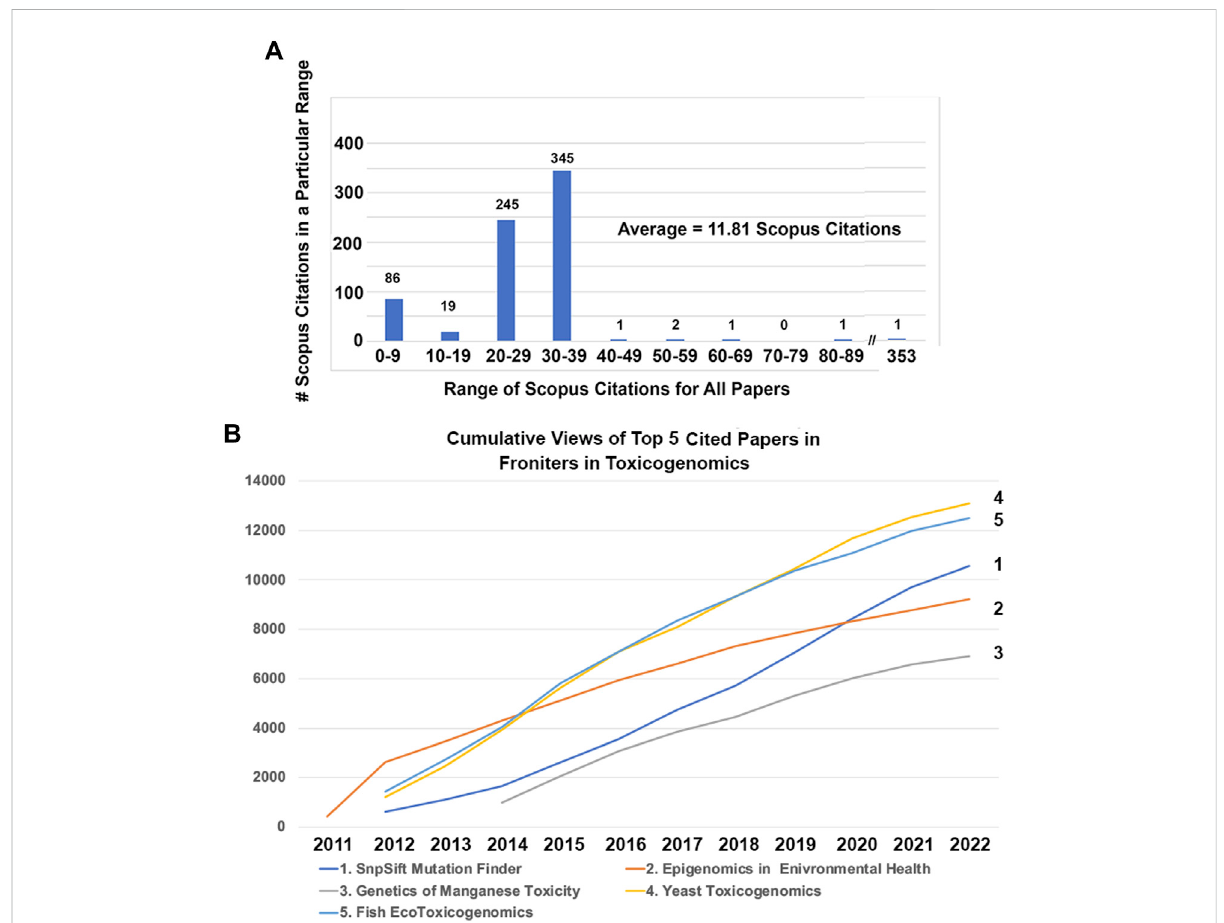
FIGURE 2 Scopus citations and views for top 5 cited publications in Frontiers in Toxicogenomics. (A) Number of Scopus citations for all publications in Frontiers in Toxicogenomics. The number of publications with 0 – 9, 10 – 19, et cetera Scopus citations are shown. The average number of Scopus citations is 11.81. One publication written by the author ’ s laboratory. (B) had 352 Scopus citations, which is an outlier compared with all of the other publications (Cingolani et al., 2012a). (B) Loop views of the publication with the largest number of Scopus citations. The publication “ Using Drosophila melanogaster as a model for genotoxic chemical mutational studies with a new program, SnpSift ” by the author ’ s laboratory had 353 Scopus citations and 8,951 views at the time of writing this review (Cingolani et al., 2012a). (C) Loop views of the publication with the second largest number of Scopus citations. The publication “ Epigenomics in environmental health ” by Drs. Christensen and Marsit had 86 Scopus citations and 8,464 views (Christensen and Marsit, 2011). (D) Loop views of the publication with the third largest number of Scopus citations. The publication “ Genetic factors and mangenese induced neurotoxicity ” by Dr. Michael Aschner ’ s laboratory, who was a co-Specialty Chief Editor for Frontiers in Toxicogenomics for 5 years, had 61 Scopus citations and 6,175 views (Chen et al., 2014). (E) Loop views of the publication with the fourth largest number of Scopus citations. The publication “ Yeast toxicogenomics: genome-wide responses to chemical stresses with impact in environmental health, pharmacology, and biotechnology ” by Dr. Sa-Correia ’ s laboratory had 59 Scopus citations and 11,994 views (Dos Santos et al., 2012). (F) The publication “ Applications for next-generation sequencing in fi sh ecotoxicogenomics ” by Dr. Denslow ’ s laboratory had 50 Scopus citations and 11, 296 views (Mehinto et al.,